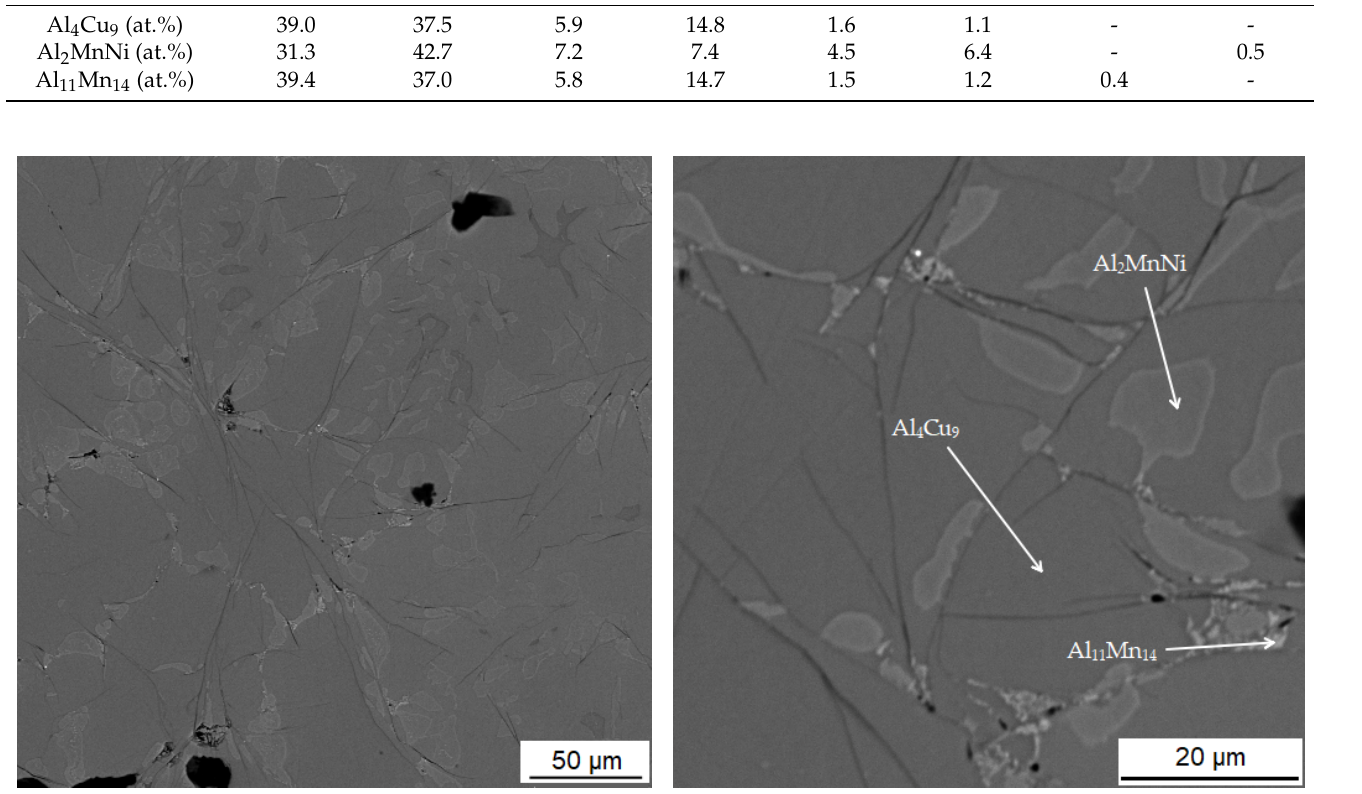
Figure 10. Microstructure of alloy with 100% excess of aluminum over stoichiometry sintered at 950 °C.